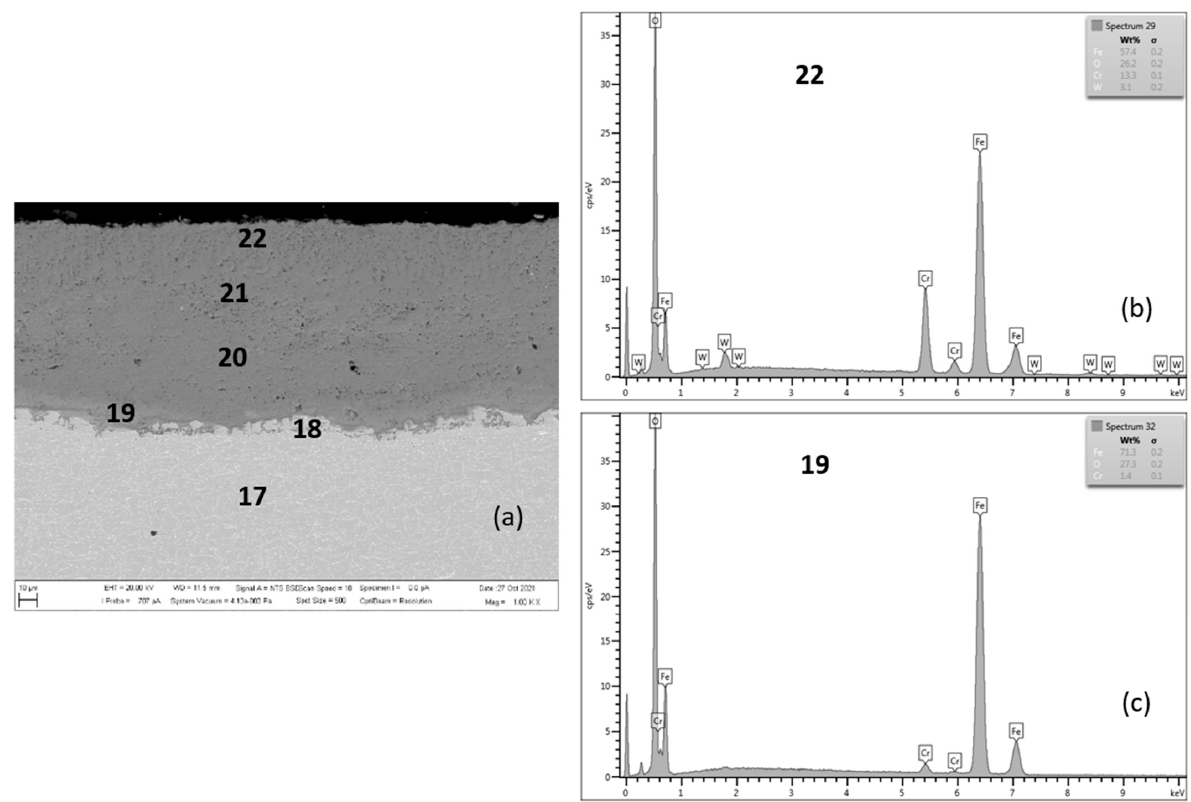
Figure 10. MarBN after 2000 h at 650 °C ( a ), EDX analysis from location 22 ( b ) (outer oxide layer) and location 19 ( c ) (interface substrate/oxide layer).